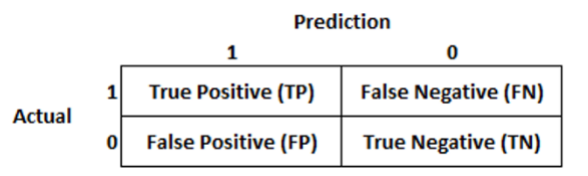
Figure 6. Confusion